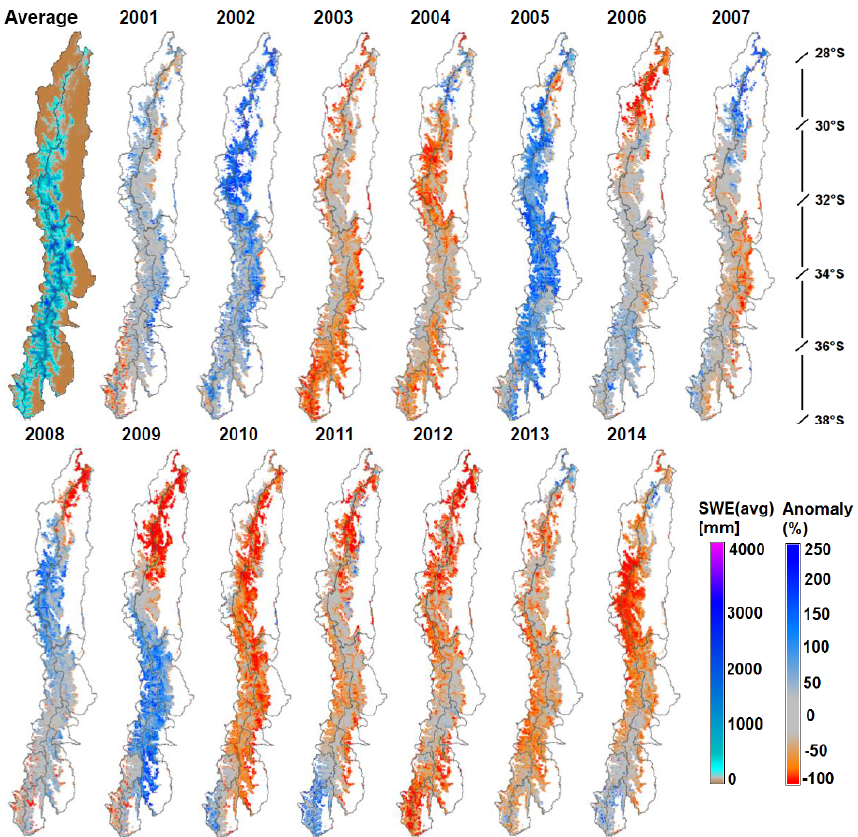
Figure 7. Regional peak (15 September) SWE climatology for the 2001–2014 period (upper left panel), and annual peak SWE anomalies.